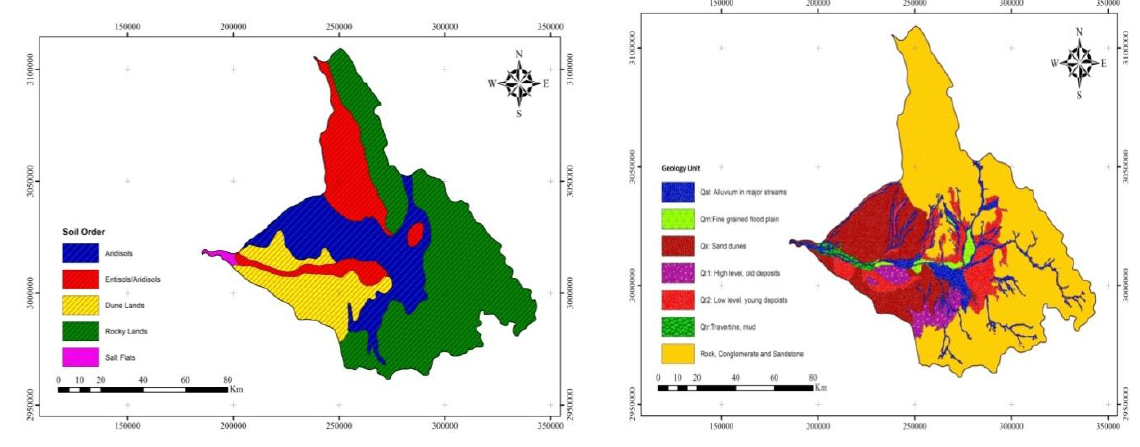
Figure 6. G eological map of Iranshahr catchment